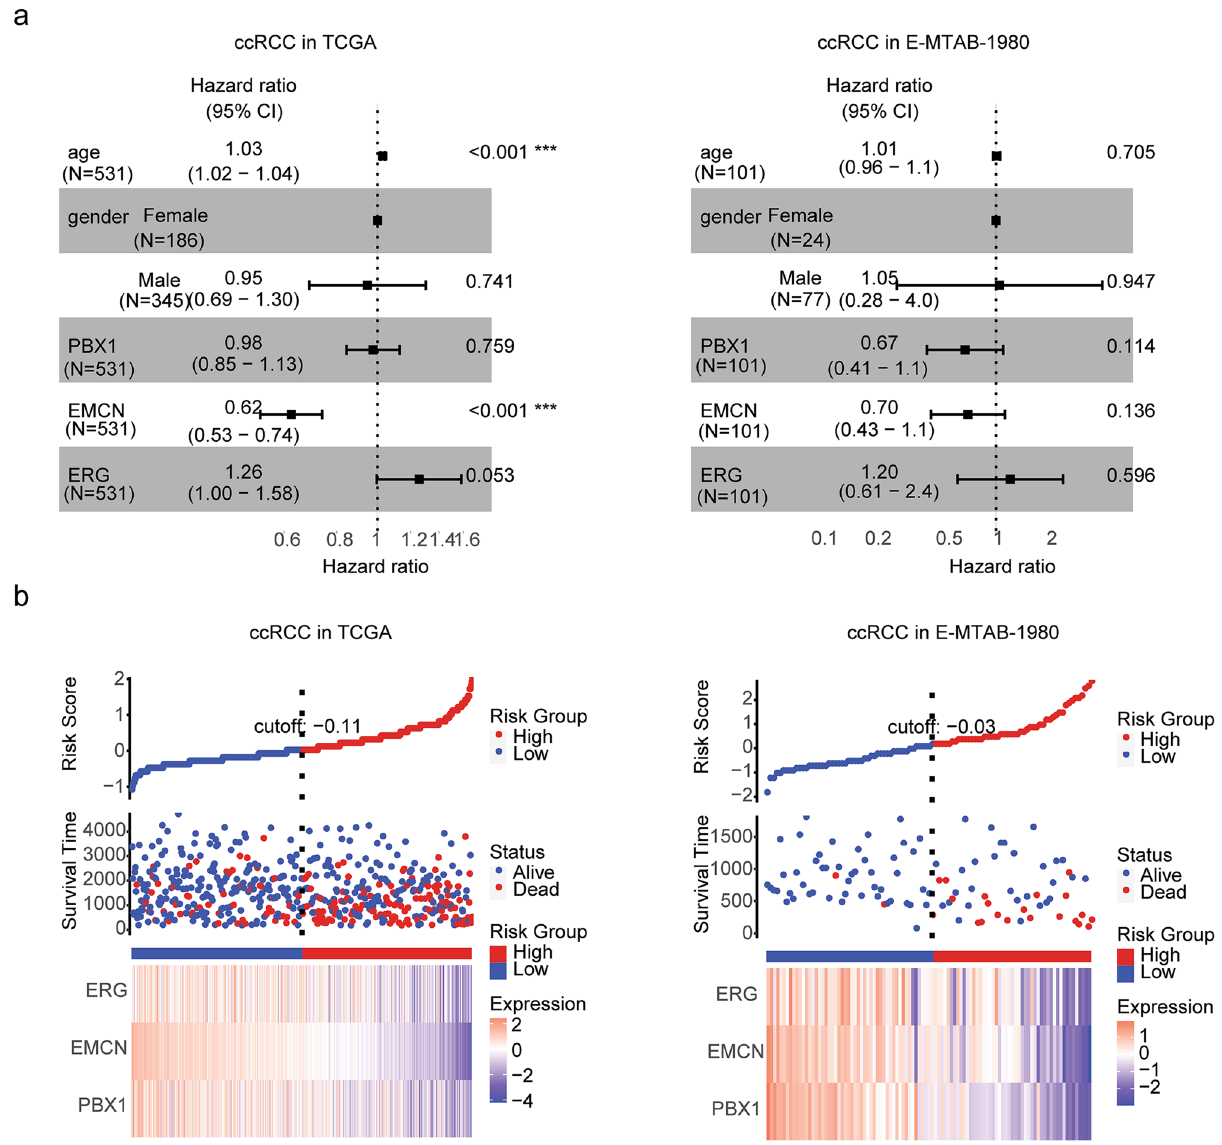
Figure 8. Construction of risk models of ccRCC based on PBX1, EMCN and EGR expressions. ( a ) Forest plots showed the associations of age, gender, PBX1, EMCN and EGR expressions with the clinical overall survival of ccRCC patients in TCGA and E-MTAB-1980 datasets. ( b ) The distribution of risk score, survival status and expression levels of PBX1, EMCN and EGR between low-risk group and high-risk group of ccRCC in TCGA and E-MTAB-1980